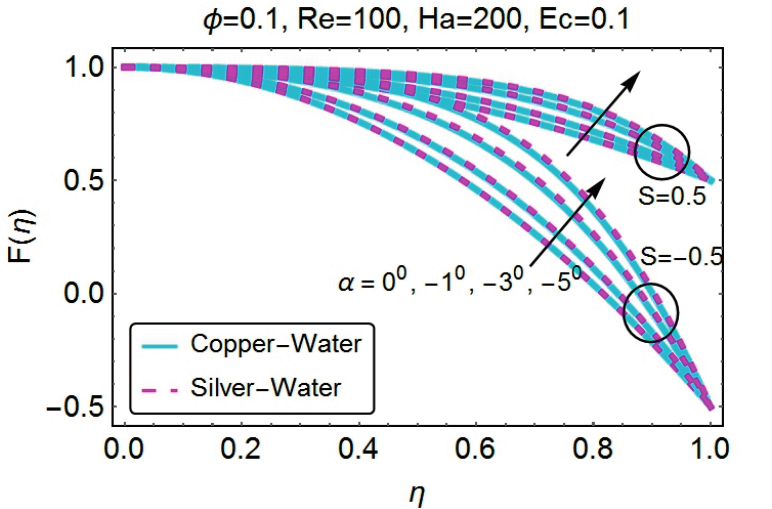
Figure 3. Change in velocity for varying α (convergent